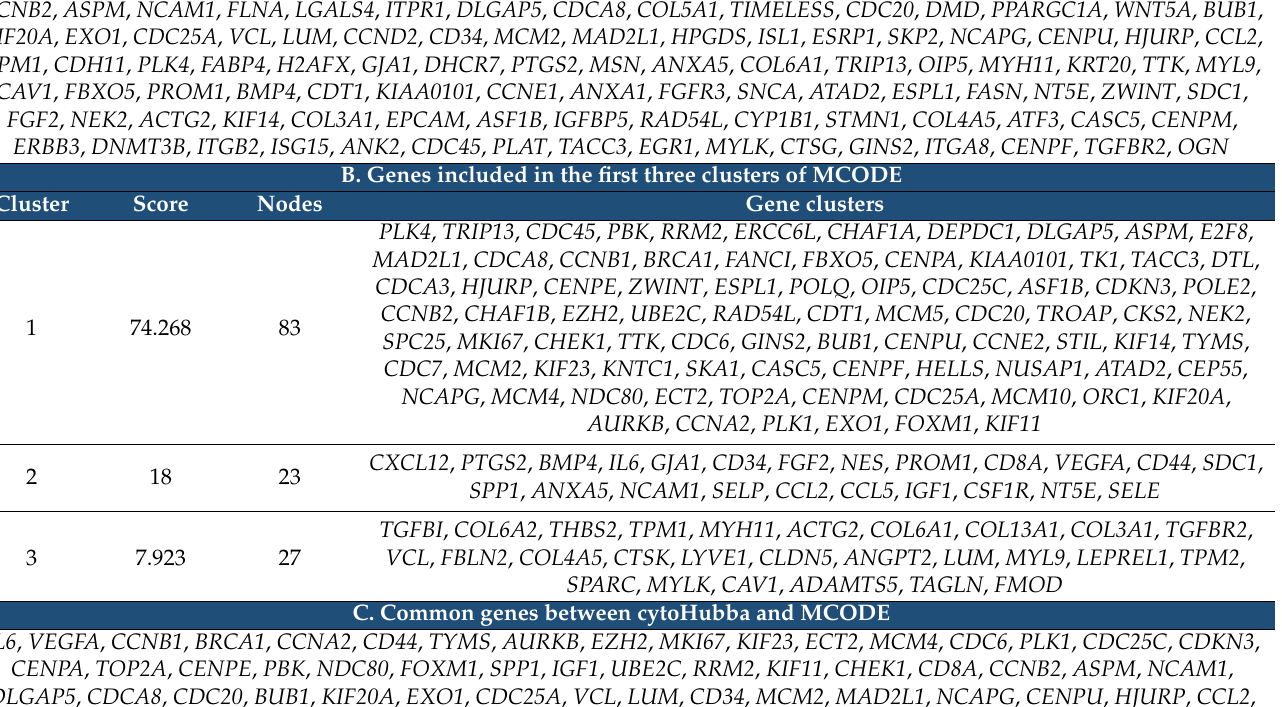
Table 3. Hub genes as obtained from cytoHubba and MCODE plugins of